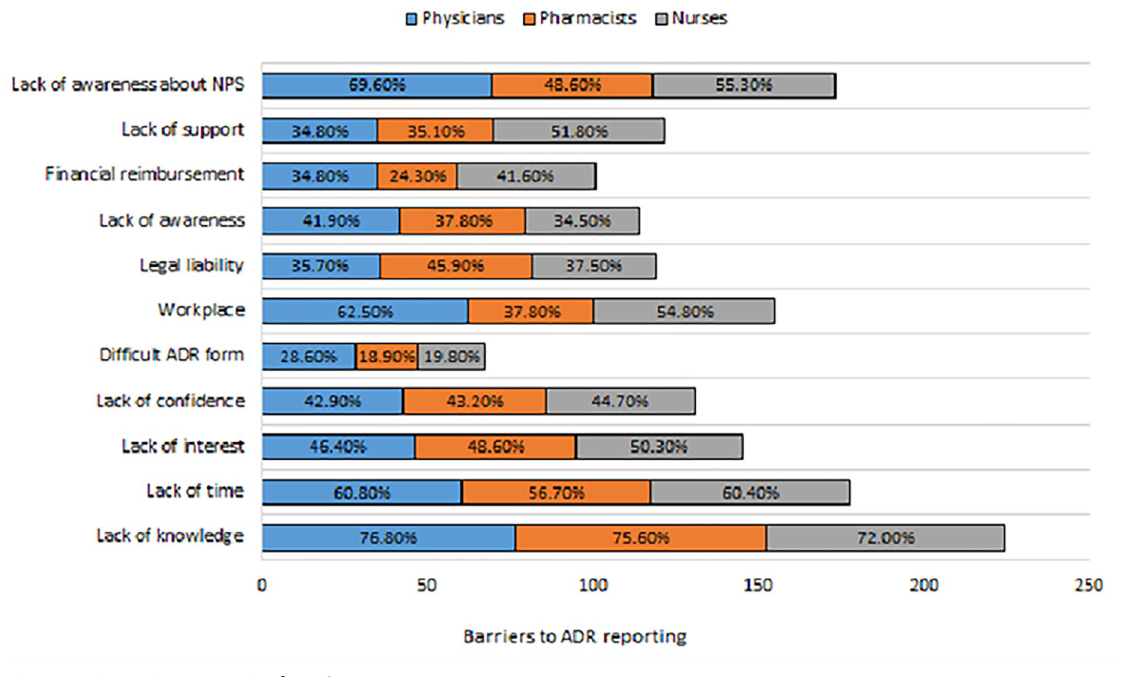
Fig 2. Barriers to ADR reporting by